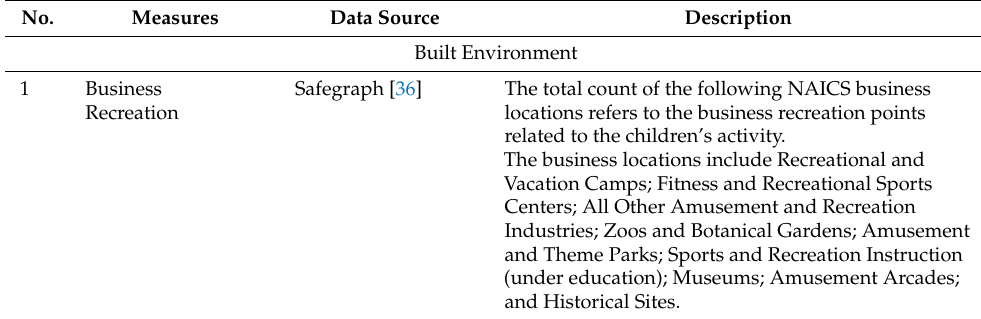
Table 1. Environmental measures